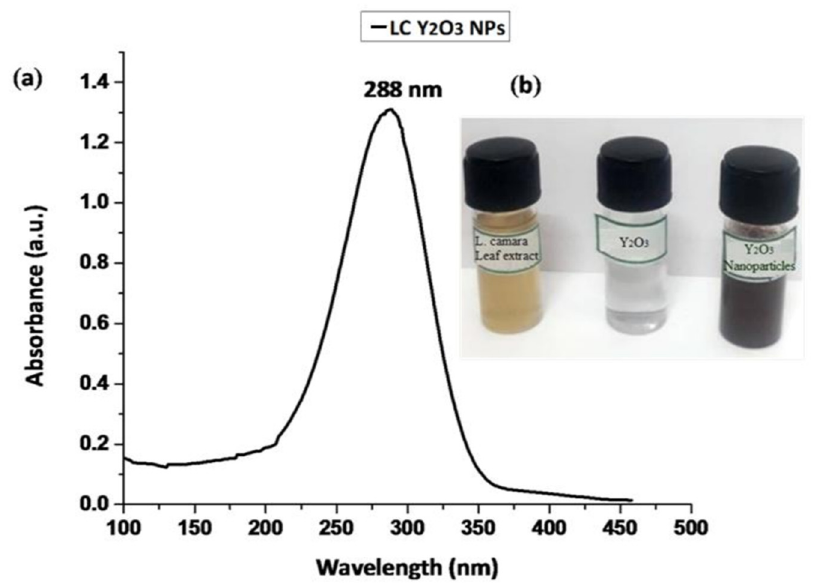
Figure 1. UV-vis absorption spectra of ( a ) green synthesized LC Y 2 O 3 NPs suspended in ethanol and ( b ) the color changes following the synthesis of LC Y 2 O 3 NPs.